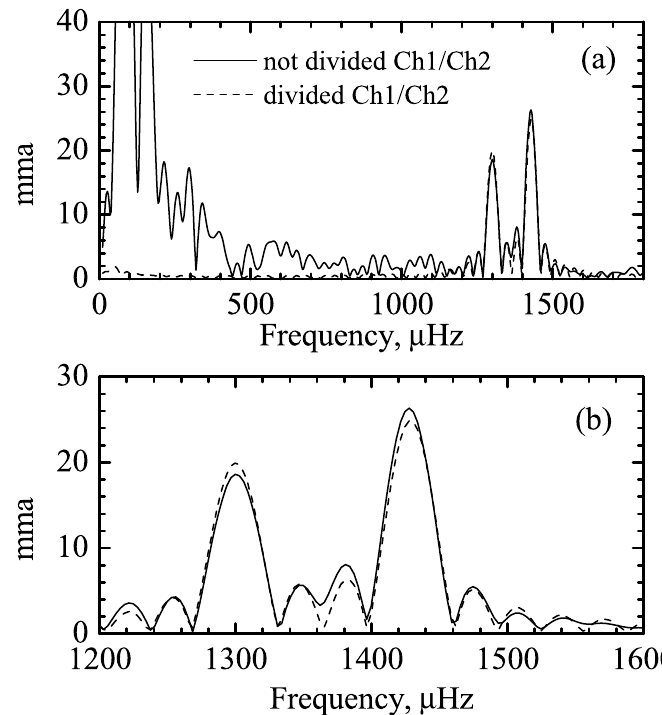
Fig. 12. Amplitudes calculated from the light curve, when the neu- tral extinction effect (clouds) was not removed (solid line) and when the effect removed by division of Ch1/Ch2 (dashed line): (a) – for frequencies between 0 and 1800 μ Hz; (b) – for frequencies between 1200 and 1600 μ